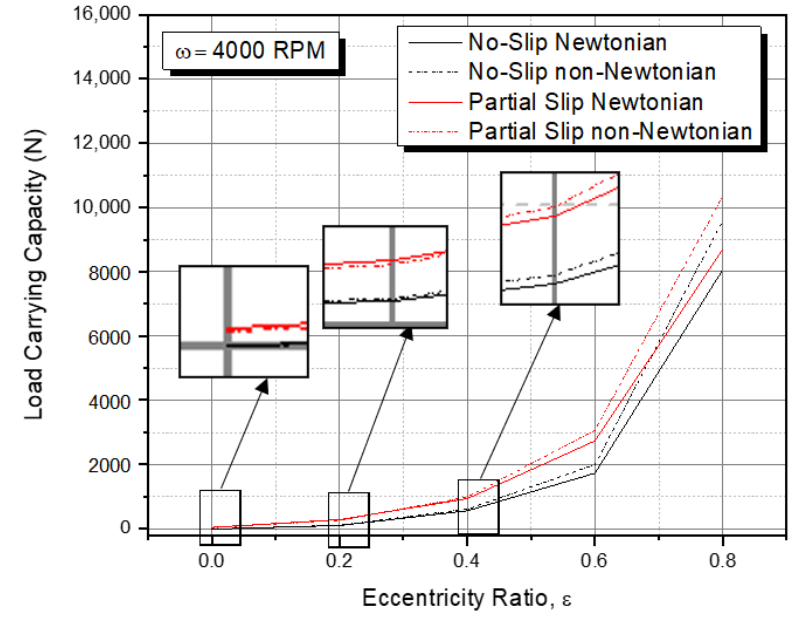
Figure 7. Load-carrying capacity of journal bearing versus eccentricity ratio for different cases.